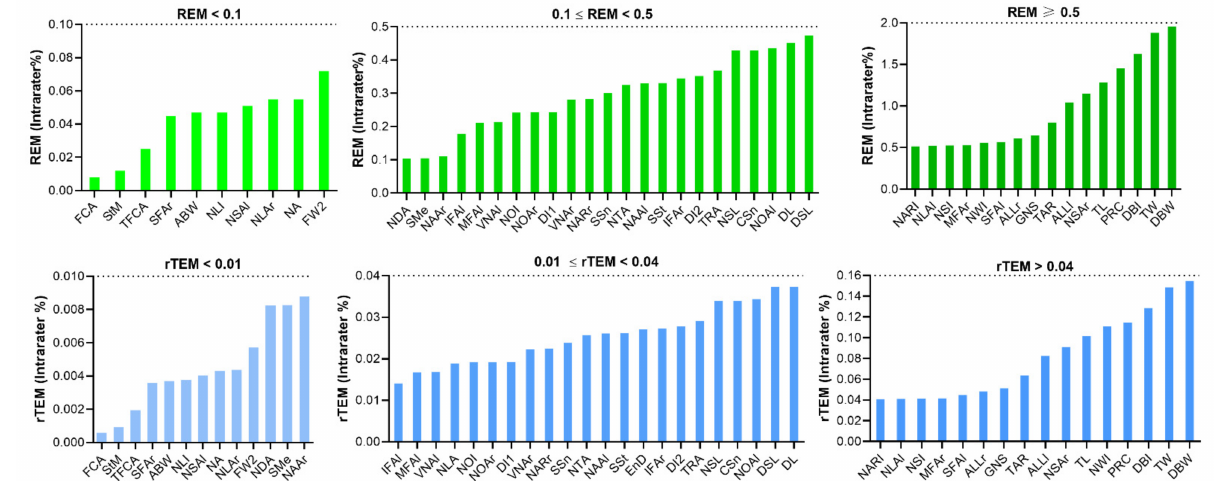
Figure 6. Intra-assessor relative error measurement (REM) and relative technical error of measure- ment (rTEM) of novel nasal measurements on three-dimensional images.